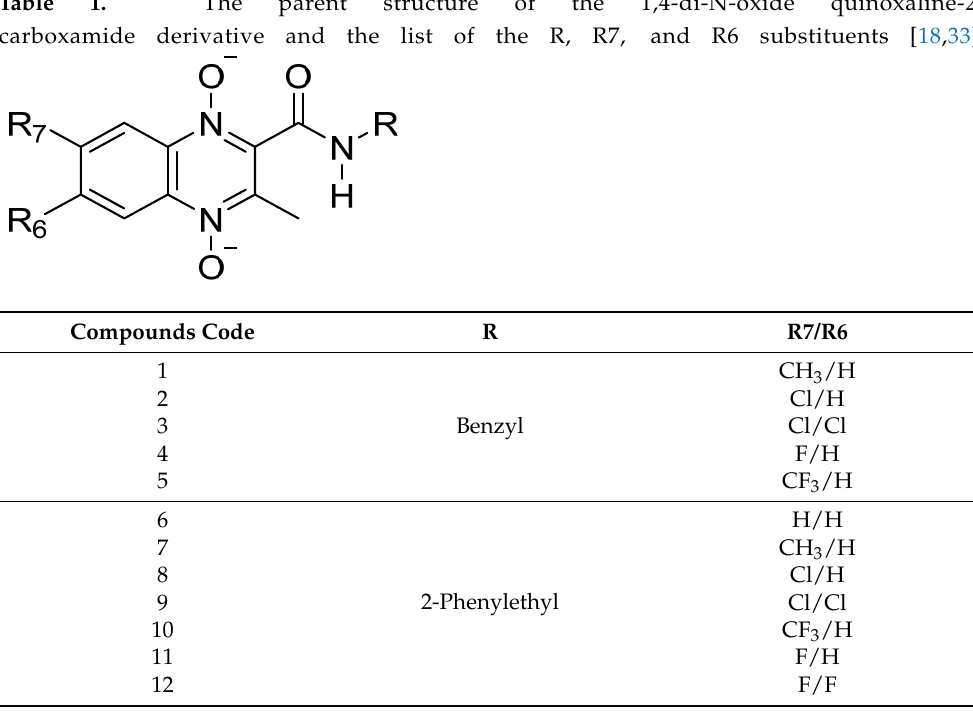
Table 1. The parent structure of the 1,4-di-N-oxide quinoxaline-2-carboxamide derivative and the 1. The parent structure of the 1,4-di-N-oxide quinoxaline-2- list of the R, R7, and R6 substituents [18,33] carboxamide derivative and the list of the R, R7, and R6 substituents [18,33].